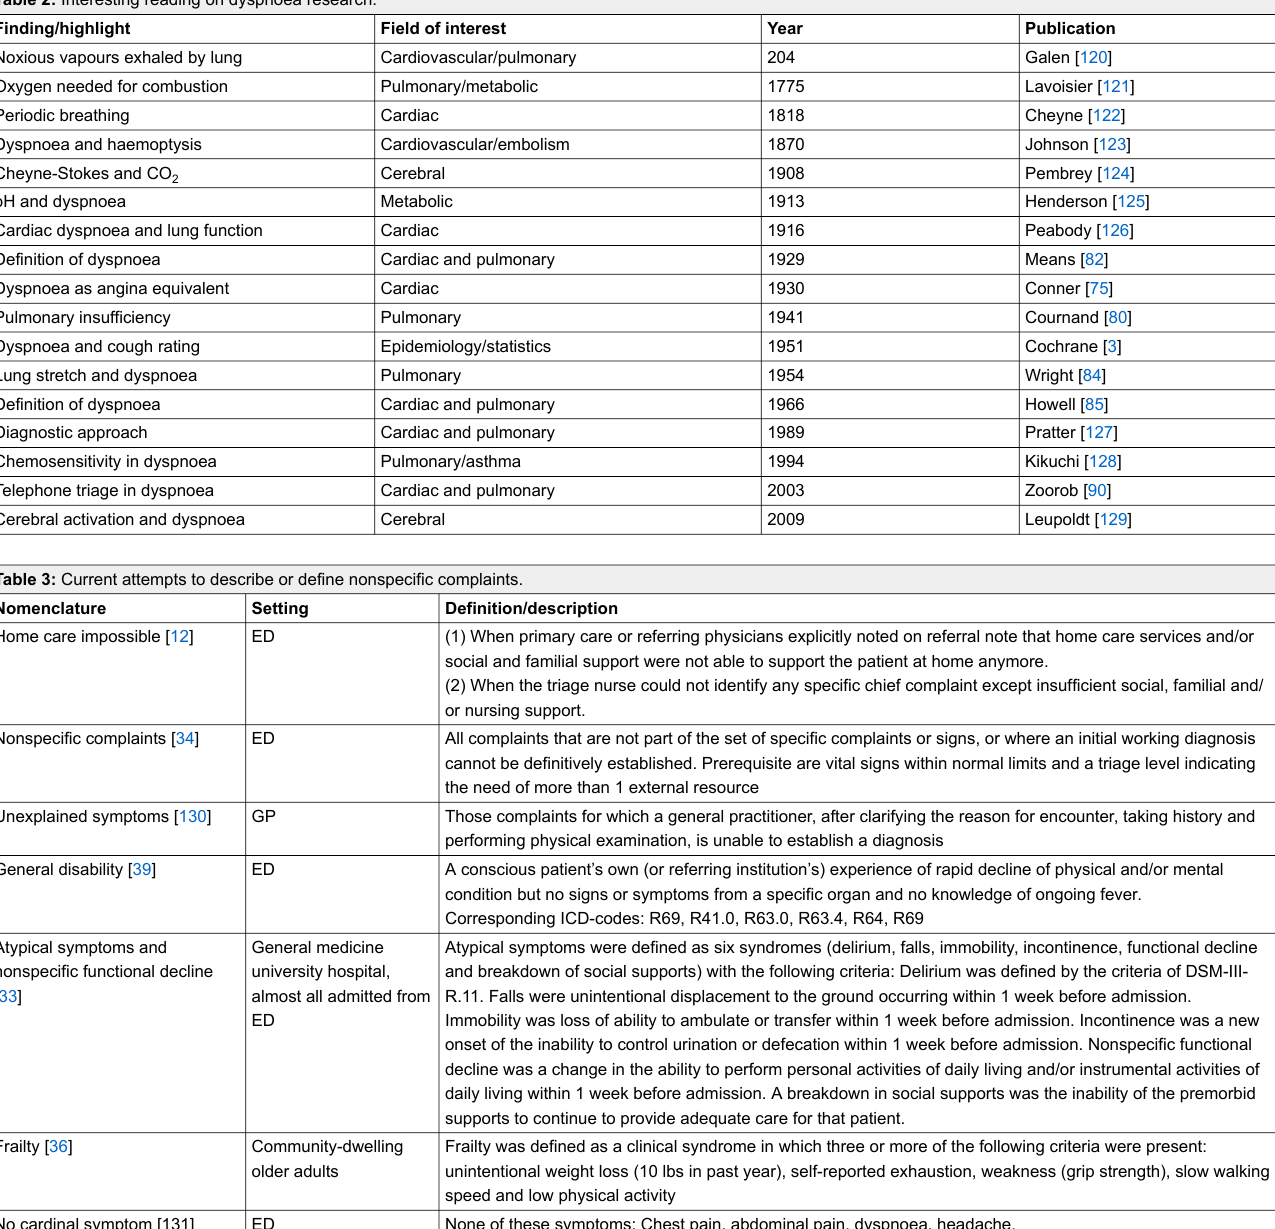
Table 2: Interesting reading on dyspnoea research.